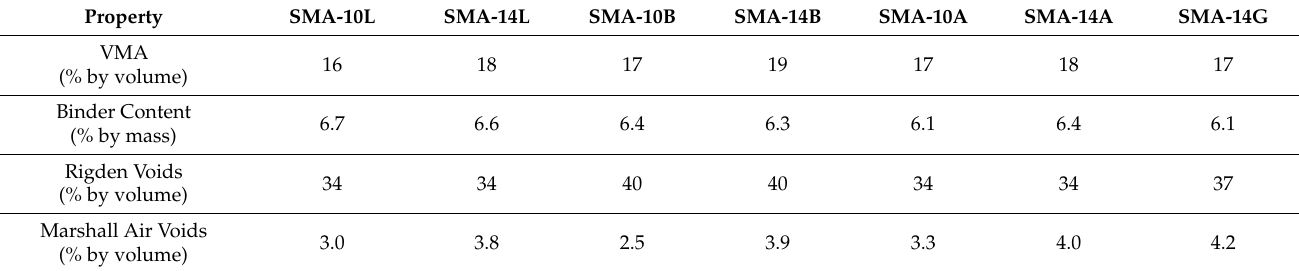
Table 8. SMA mixture other volumetric results.